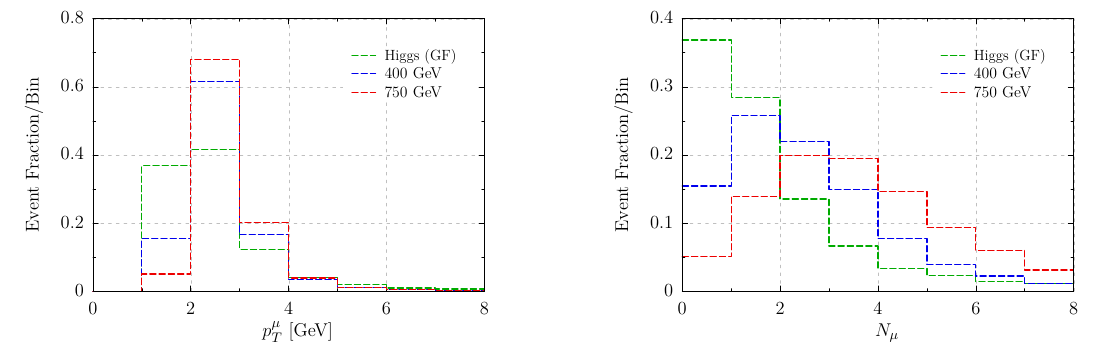
Figure 7. Left: reconstructed p T distribution of the hardest muon, after propagation through the inner detector, with j (cid:17) j < 4 : 9. Right: number of muons with p T > 2 GeV and j (cid:17) j < 4 : 9, that escape the calorimeters.